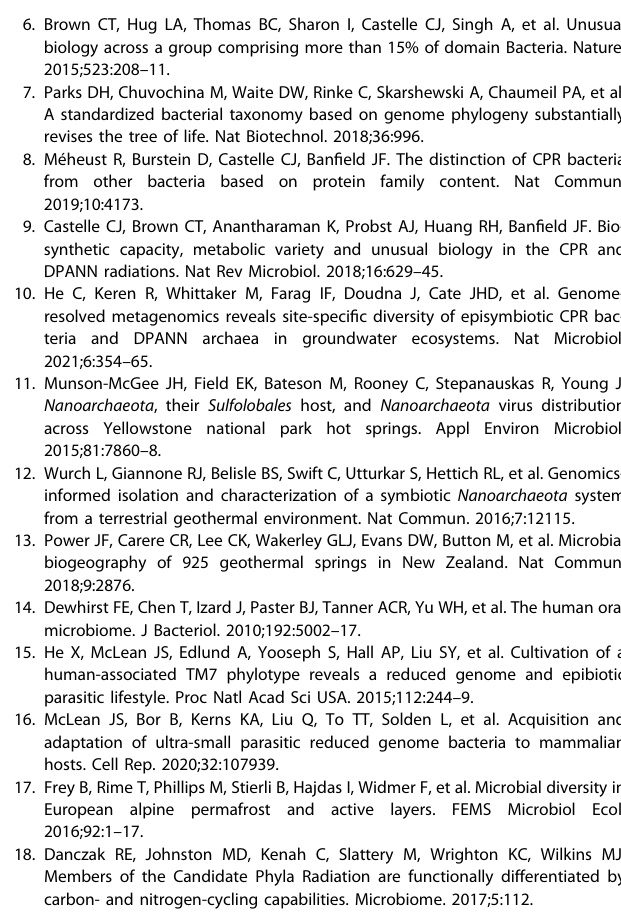
Fig. 8 Co-occurrence of ultra-small prokaryotes across the 16 genomically-characterized groundwater samples. a Co-occurrence network of ultra-small microorganisms constructed based on relative genome abundance data and Spearman ’ s rank correlation coef fi cients. Only signi fi cant positive correlations are displayed ( ρ > 0.8, p -value < 0.001). b Frequency of MAGs per cohort (left). Example of highly correlated genome relative abundance pro fi les of two ultra-small prokaryote cohorts across 16 groundwater samples (right). Cohorts were identi fi ed from genome relative abundance pro fi les using hierarchical clustering ( “ ward.D2 ” method) and con fi rmed using Spearman ’ s rank correlation analysis. Chemical parameters were scaled between 0 and